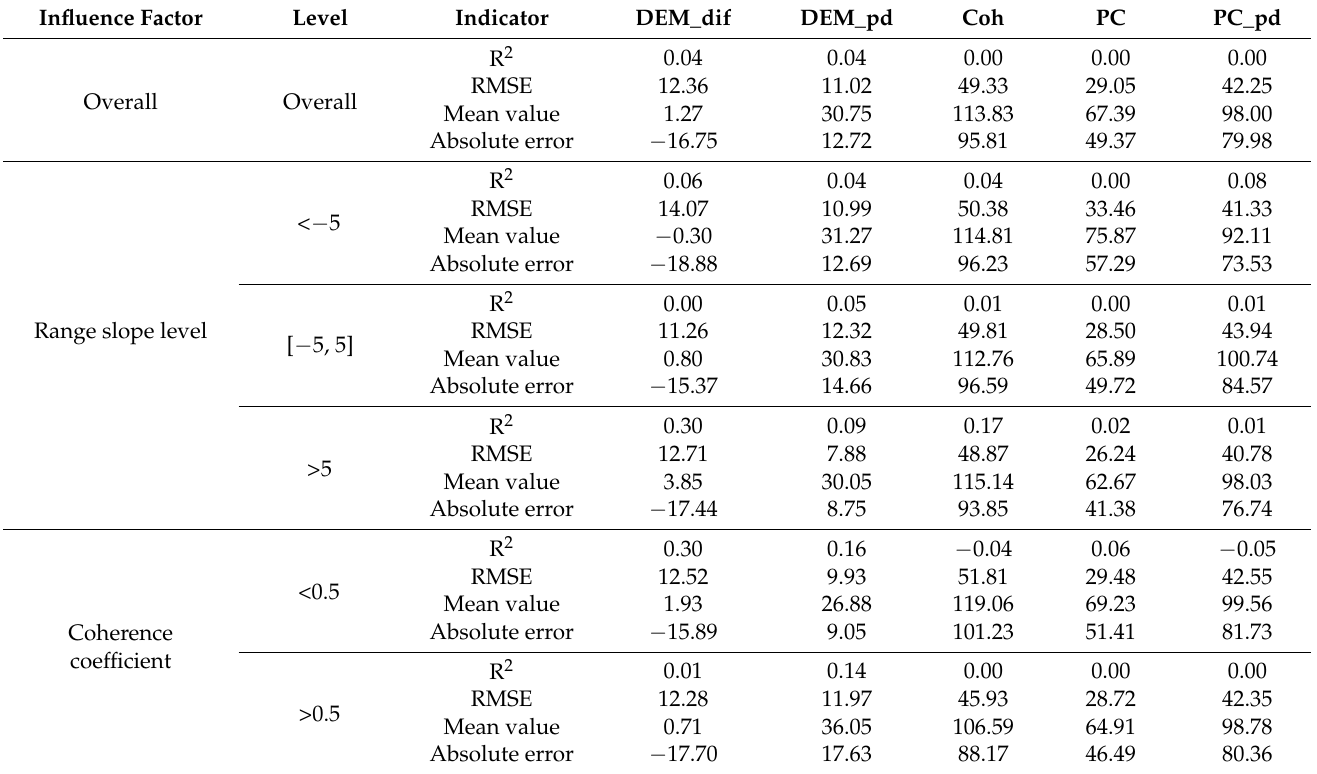
Table 6. The error table of the estimation methods for